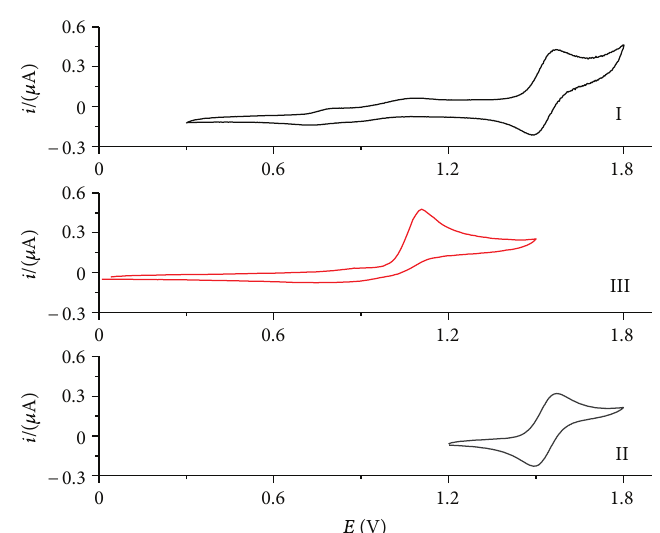
F 4: Cyclic voltammograms of complexes I , II and III (1mM), TBPF